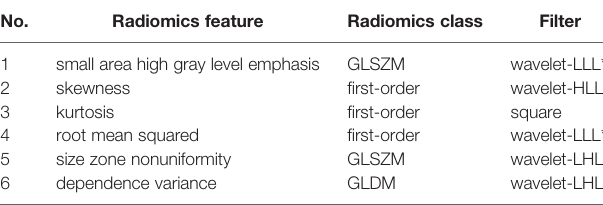
TABLE 2 | The selected radiomics